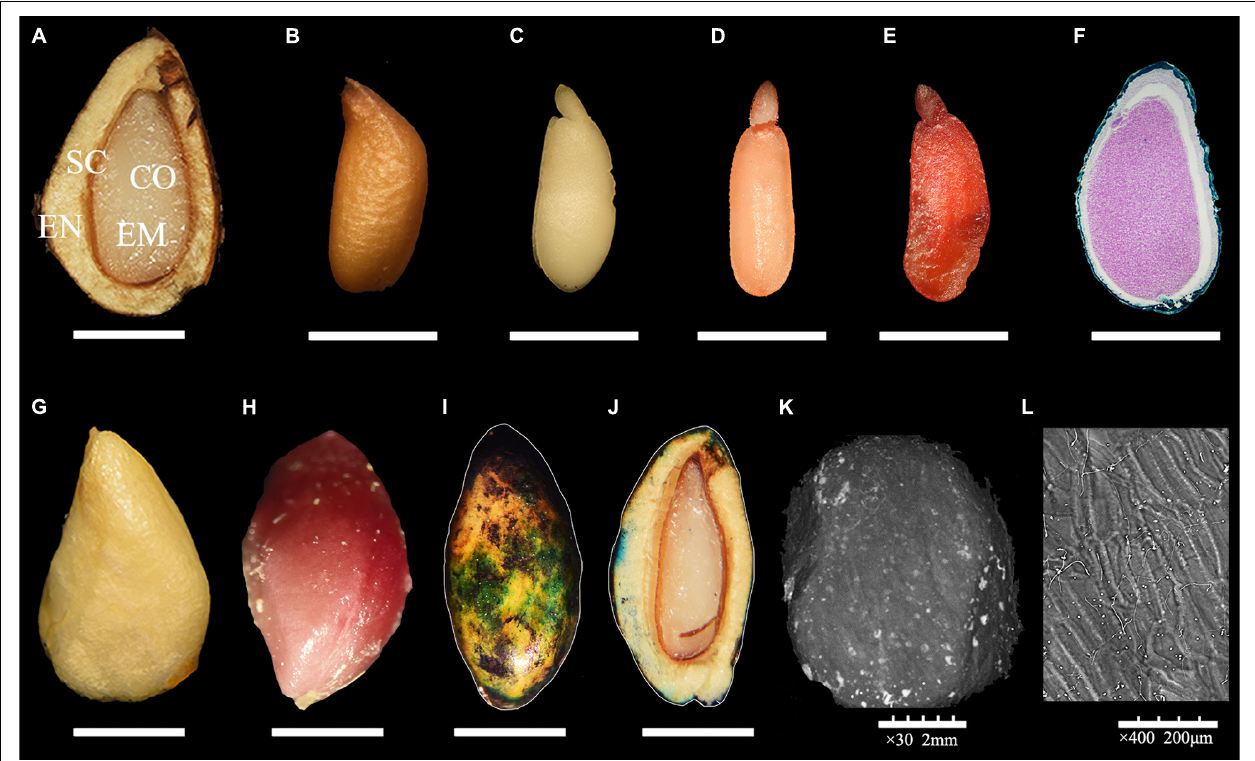
FIGURE 1 | Morphology of Rosa rugosa seed. (A) Inside of seed in longitudinal section. Outer side of seed coat (B) and embryo in longitudinal section (C) . Bad (D) and healthy (E) embryos dyed with 0.5% 2,3,5-triphenyltetrazolium chloride (TTC) staining solution. (F) Rudimentary embryo. (G) Hard and thick endocarp (G) with lignin dyed red with phloroglucinol (H) . The outside (I) and inside (J) of the seeds that were penetrated by small volume of methylene blue solution. Scanning electron microscope observations of R. rugosa endocarp at 30 × (K) and 400 × (L)